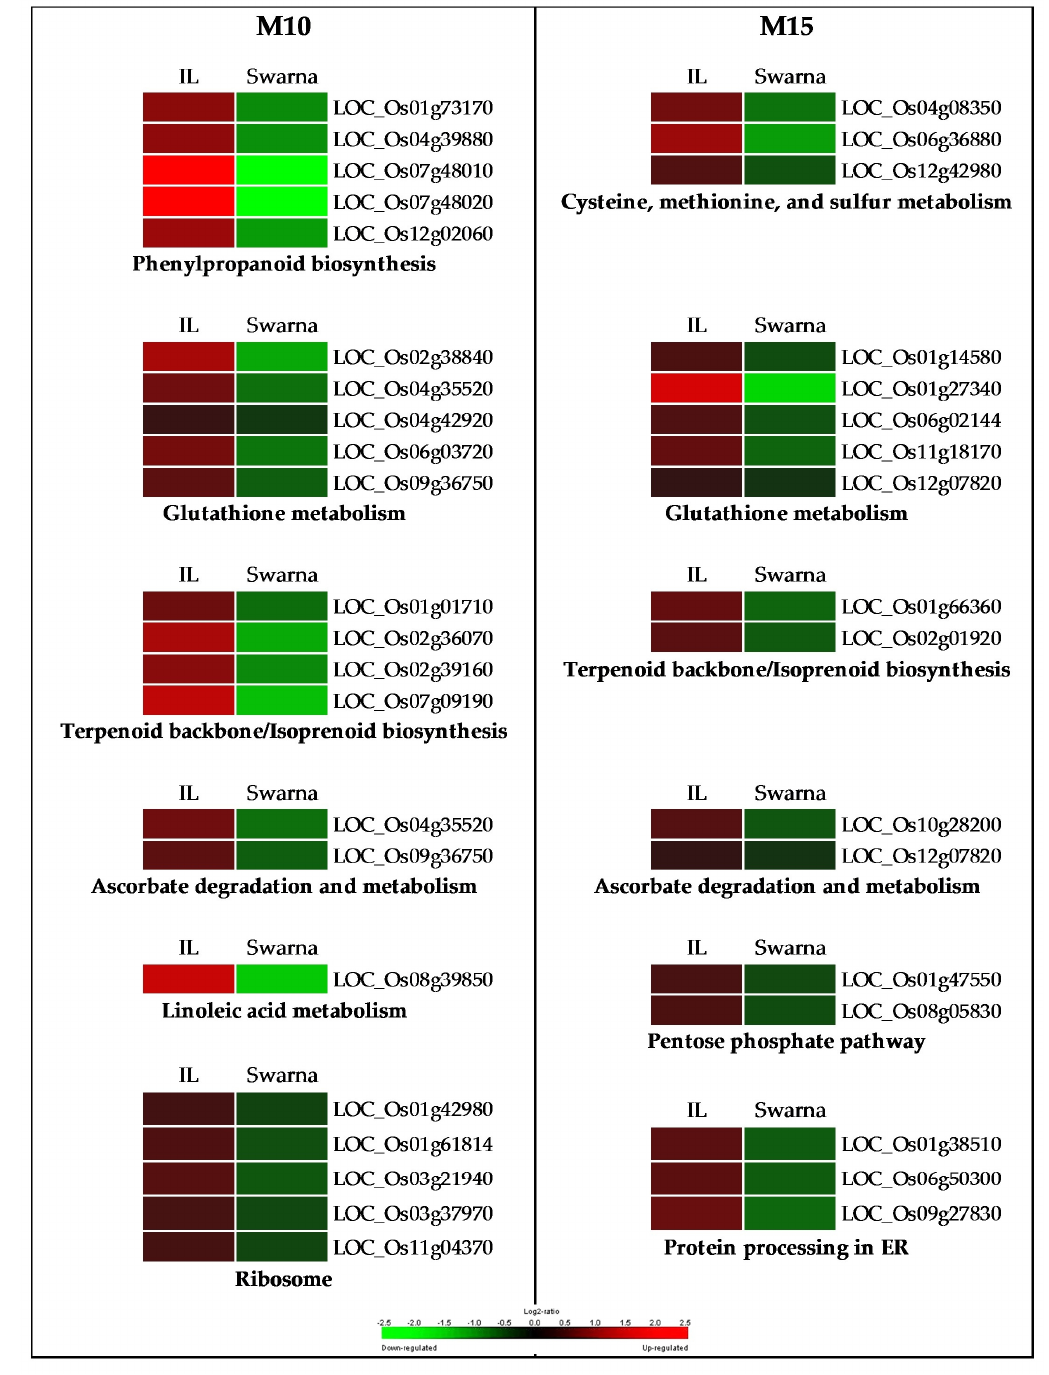
Figure 9. Regulation of metabolic pathways during RDS in panicle. The metabolic pathways enriched in the drought-responsive modules P-M10 (M10) and P-M15 (M15) between DTY-IL and Swarna under RDS are shown in heat-maps representing their expression profile. The scale represents a log 2 fold change in expression. IL = DTY-IL.